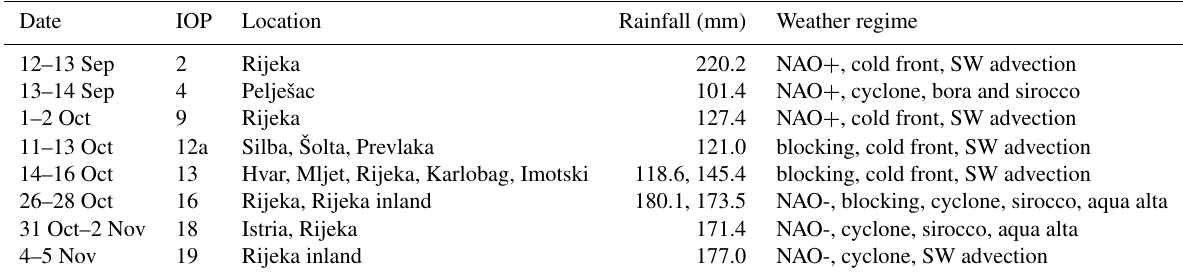
Table 2. HPEs over the Adriatic TA during SOP1. The column titled Rainfall lists the maximum 24h accumulated precipitation (from 06:00 to 06:00UTC). Weather regime gives associated large scale